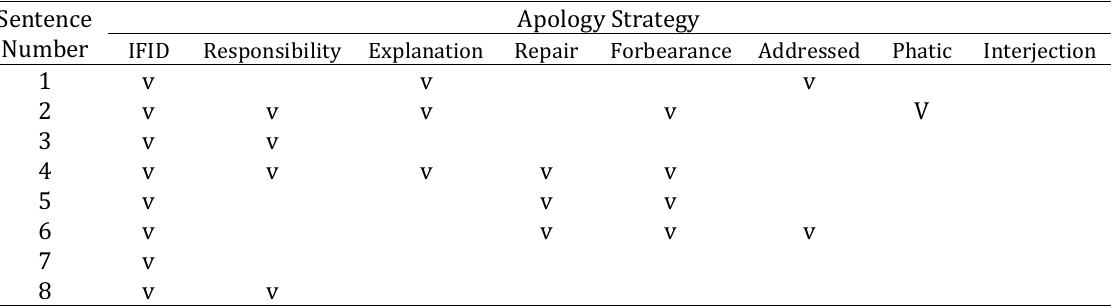
Table 1 Apology Strategy on TV Sitcom Friends